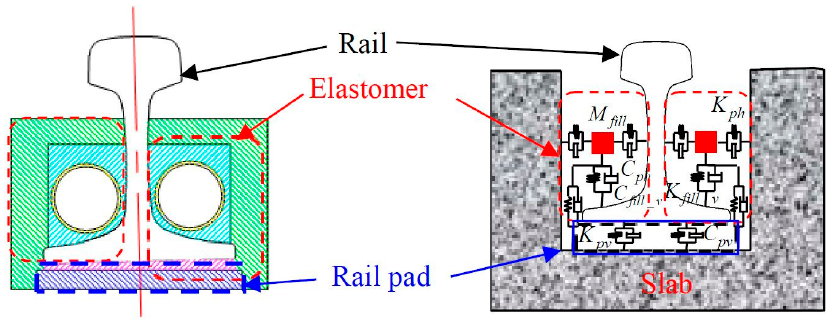
Figure 3. Dynamic model of filling material in groove.